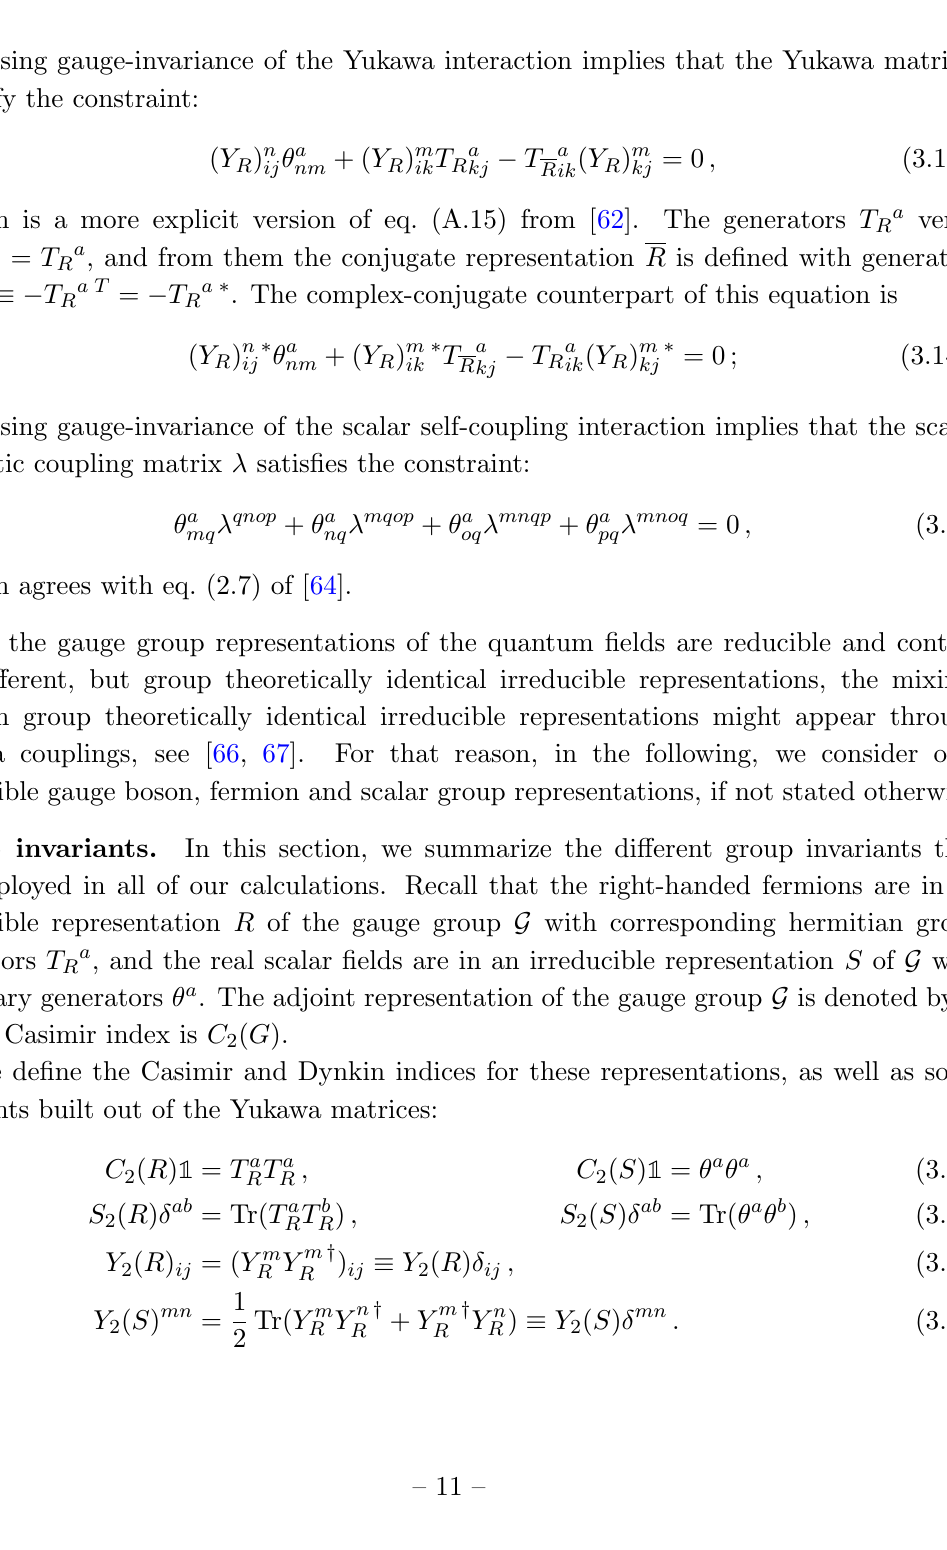
mass dim. comm. Table 1. List of (cid:12)elds, external sources and operators, and their quantum numbers. imposing gauge-invariance of the Yukawa interaction implies that the Yukawa matrices (cid:15) satisfy the constraint: